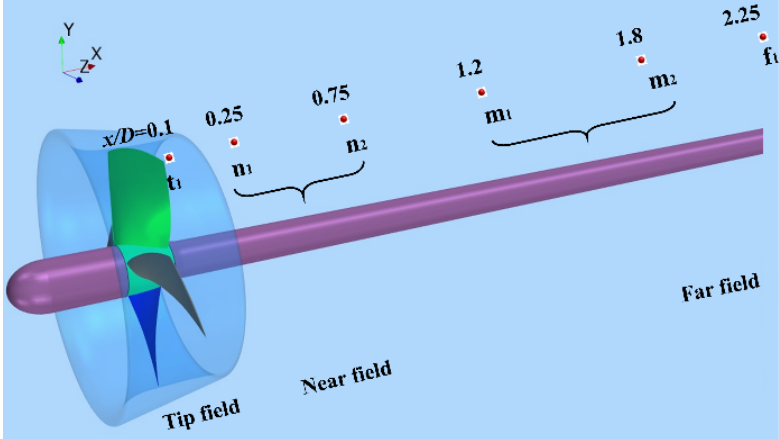
Figure 15. Layout of the wake measuring points. As shown in Figure 16, overall, from the tip field to the far-field, the frequen- cy-domain distribution of the pressure measurement points mainly underwent two changes: (1) From the tip area to the near-field, the pressure frequency distribution shifted from nf b to f b , (where n = 2,3,4,5…), which was the main blade frequency. It was preliminarily inferred that this was due to the gradual dissipation of the STLV or its in- teraction with the PTLV. (2) From the near-field to the far-field, the main frequency of the pressure shifted from the main blade frequency to lower frequencies, including 0.5 f b and 0.25 f b , as a consequence of the vortex structure’s evolution in the far-field. Due to the short-wave instability of the TLV, a large number of secondary vortices were generated, and their shedding frequency was irregular.